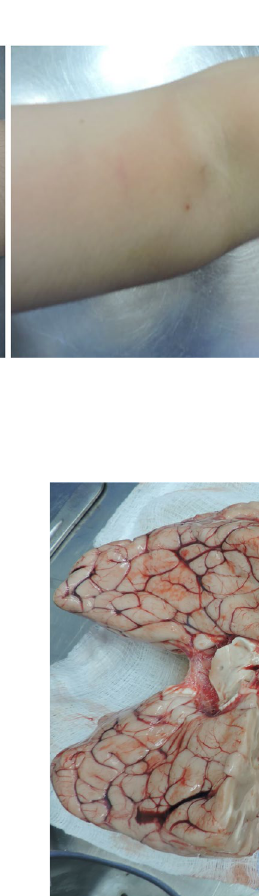
Fig. 8 Needle mark over the lateral aspect of the left ankle